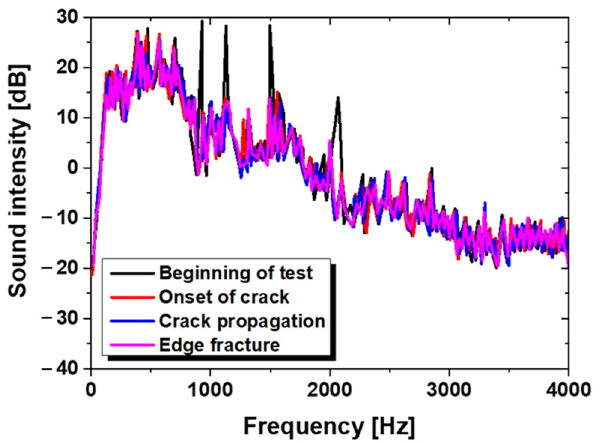
Figure 10. Acoustic measurement and FFT analysis during hole expansion test .